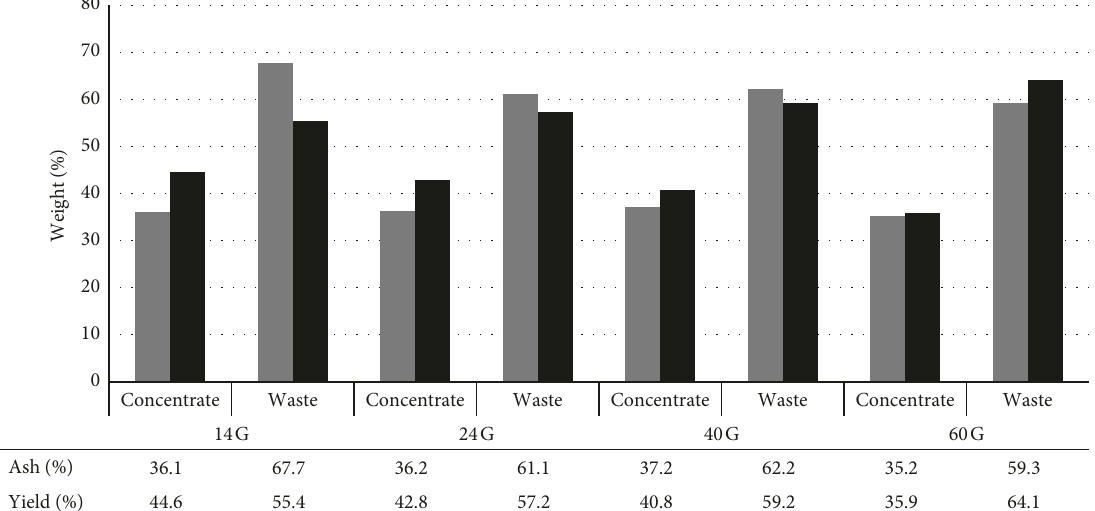
Figure 9: Enrichment concentration graphic of Sample-C2 coal with Knelson method (